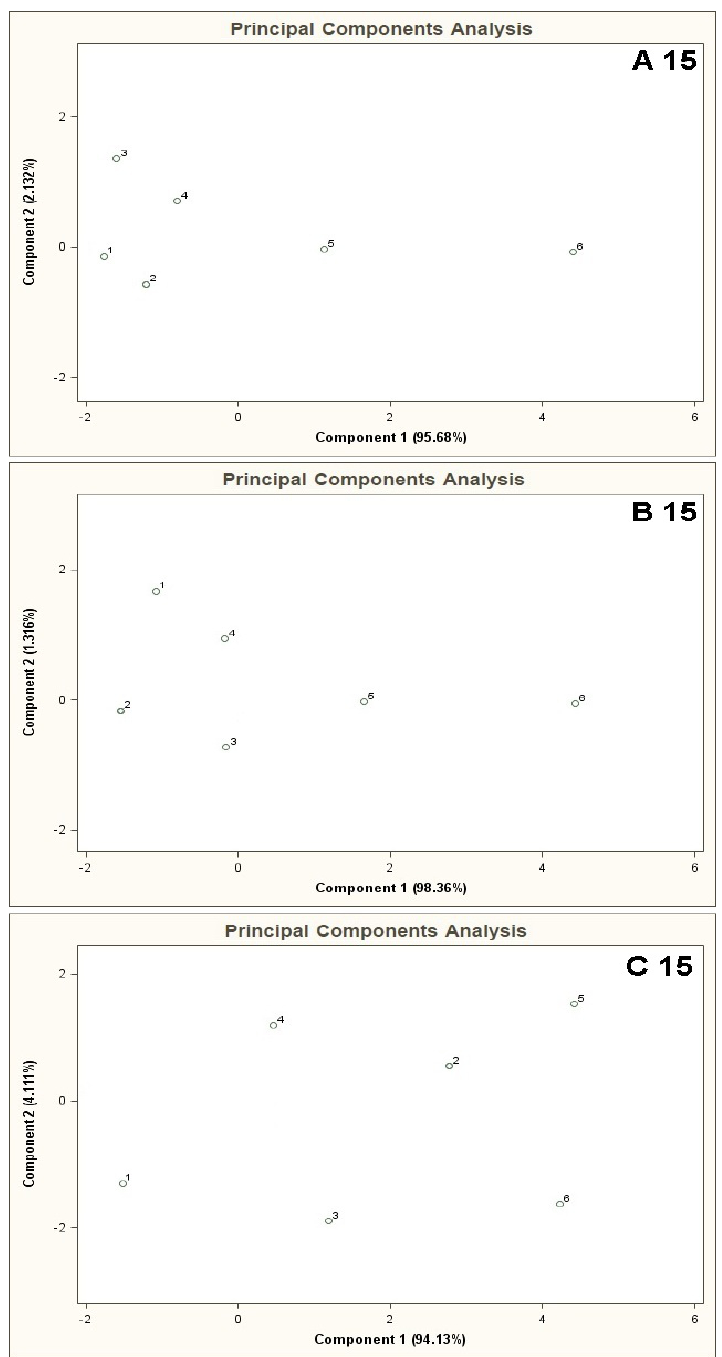
Figure 6. Result of PCA for the mixtures of type A 15 , B 15 , C 15 , where A 15, B 15, C 15 are the aqueous solutions of the basic components (acetone, isoprene, carbon disulphide, propan-2-ol, formamide, benzene, toluene, acetonitrile, acetic acid, dimethyl ether, dimethyl sulphide, acrolein, furane, propanol, pyridine) having the concentration of each component in the mixture equal 10 ppb, 25 ppb and 50 ppb v/v, respectively. 1–6 are the mixtures of reference substances with the COPD markers of the respective concentrations: 0